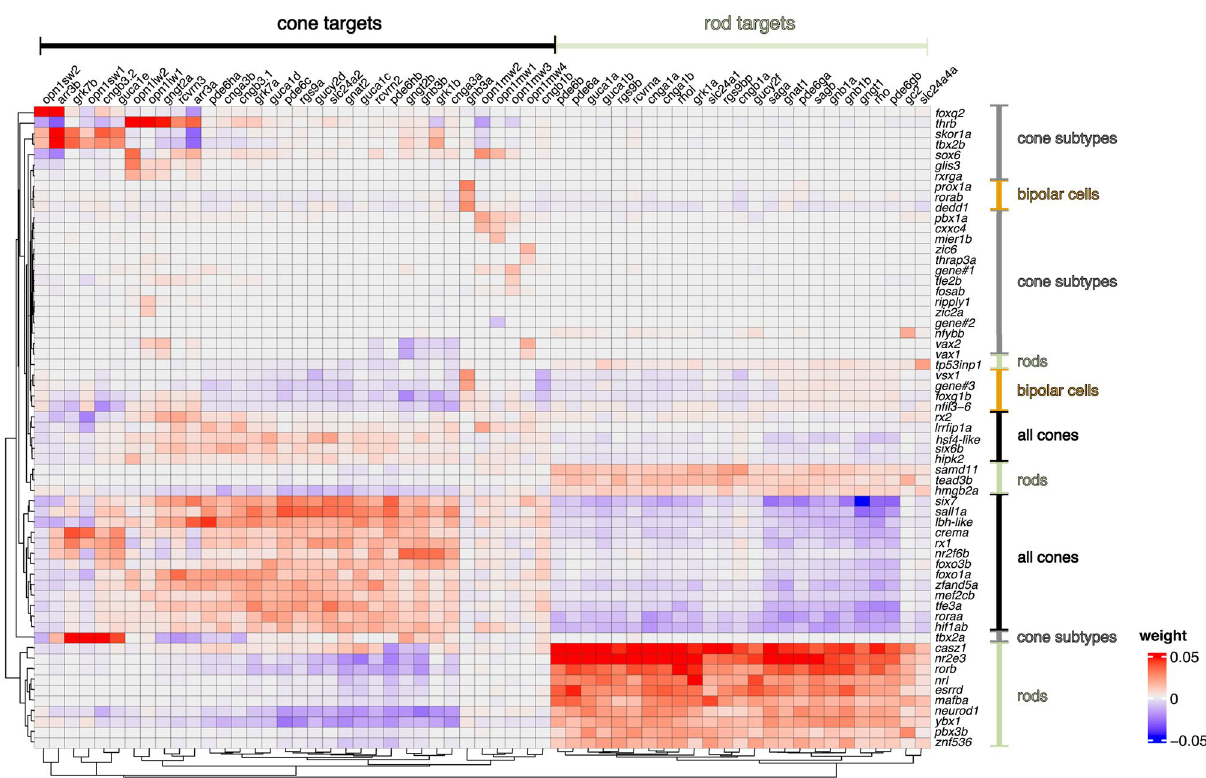
Figure 4. Candidate transcriptional regulators responsible for expression of phototransduction genes. Heatmap showing positive (red) and negative (blue) associations between transcriptional regulators (transcription factors and cofactors) and differentially expressed phototransduction genes (target genes) calculated by GENIE3 algorithm in SCENIC. Rows and columns are arranged according to divisive hierarchical clustering (dividing clusters in a top-down manner). The (dis)similarity of observations was calculated using Euclidean distances. Cell type expression patterns of the transcriptional regulators are presented in Fig. S5A. Gene#1: zgc:114046; Gene#2: zgc:110269; Gene#3: